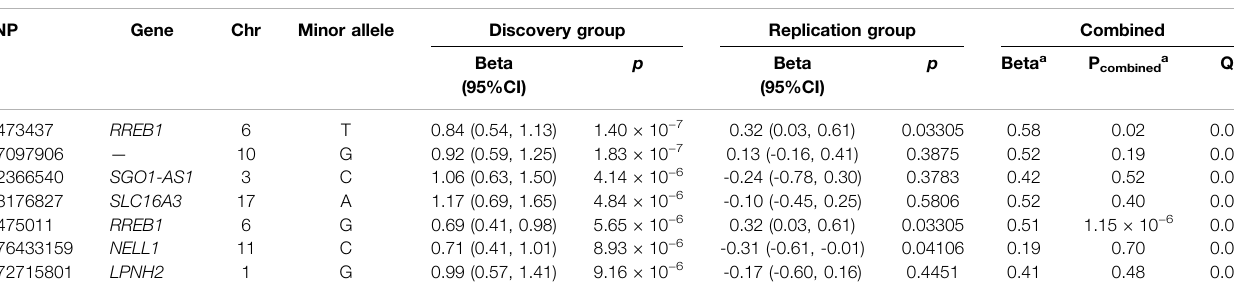
TABLE 2 | SNPs showed trend of association with BMD in PMO